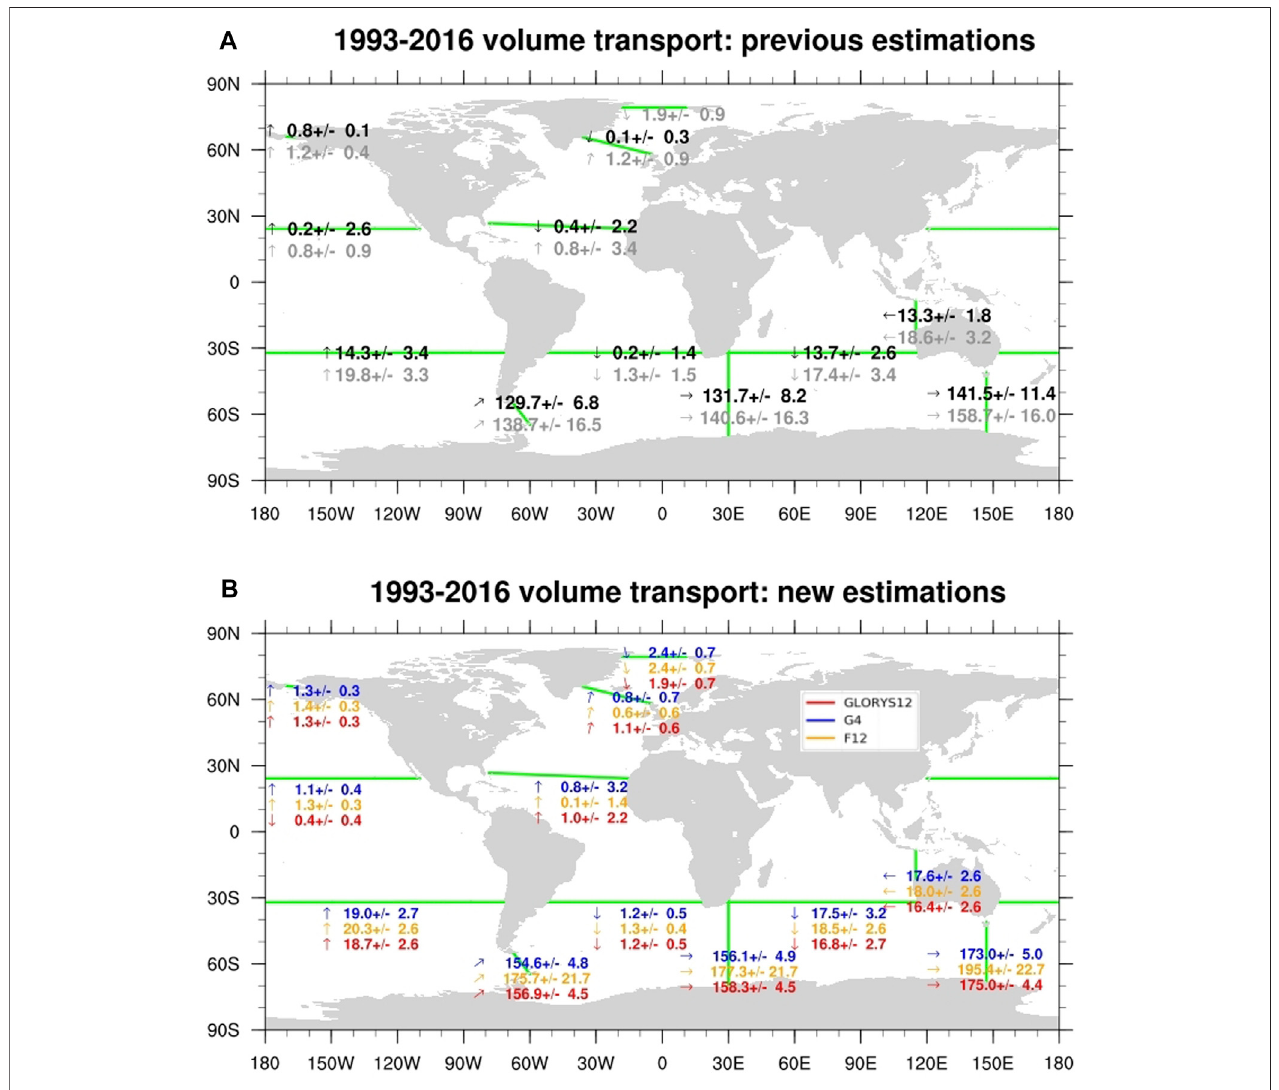
FIGURE7| Meanvolume transportand itsvariabilityforthe1993 – 2016period from (A) Lumpkin(inblack) andGREP1/4 ° ensembleproduct(in grey)andfrom (B) GLORYS12 (in red), F12 (in orange) and G4 (in blue). Units are in Sv.